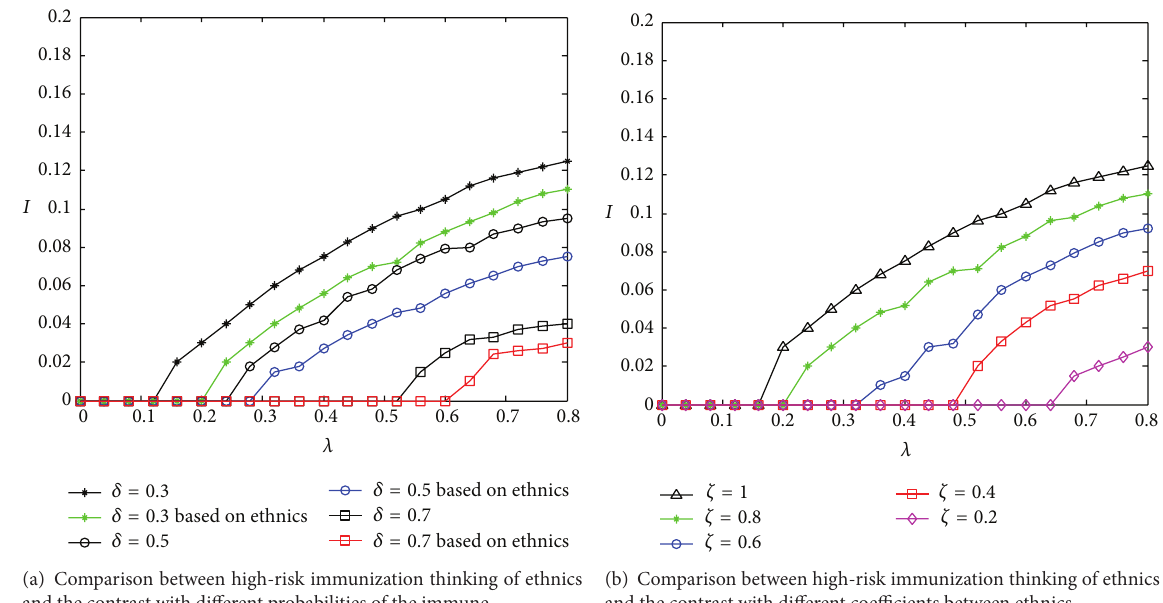
(a) Comparison between high-risk immunization thinking of ethnics (b) Comparison between high-risk immunization thinking of ethnics and the contrast with different probabilities of the immune and the contrast with different coefficients between ethnics Figure 4: The computer simulations of SIRS model with high-risk immunization on BA scale-free networks ( 𝑁 = 2000 , ⟨𝑘⟩ = 6 ). (a) The changing of infected density 𝐼(𝜆) as a function of 𝜆 , with 𝛿 = 0.3 , 𝛿 = 0.5 , and 𝛿 = 0.7 . 𝜁 𝐴𝐵 = 𝜁 𝐵𝐶 = 𝜁 𝐴𝐶 = 0.7 . (b) The changing of infected density 𝐼(𝜆) as a function of 𝜆 , with 𝜁 = 0.2 , 𝜁 = 0.4 , 𝜁 = 0.6 , 𝜁 = 0.8 , and 𝜁 = 1 ( 𝜁 𝐴𝐵 = 𝜁 𝐵𝐶 = 𝜁 𝐴𝐶 = 𝜁 ). 𝛿 = 0.3